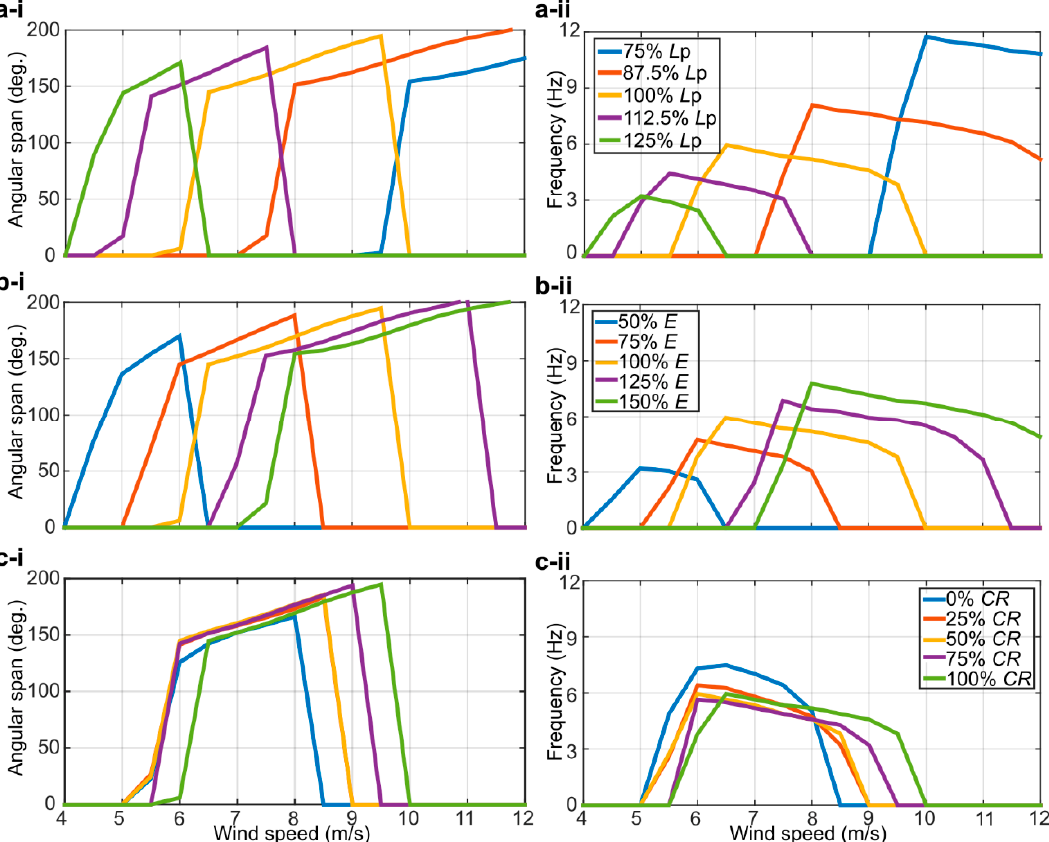
Figure 10. Sensitivity analysis on the dynamics of the full-solar flag. Effect of varying ( a ) the flag length, ( b ) the Young’s modulus, and ( c ) the coverage ratio. ( i ) Angular span of motion vs. wind speed; ( ii ) flapping frequency vs. wind speed.